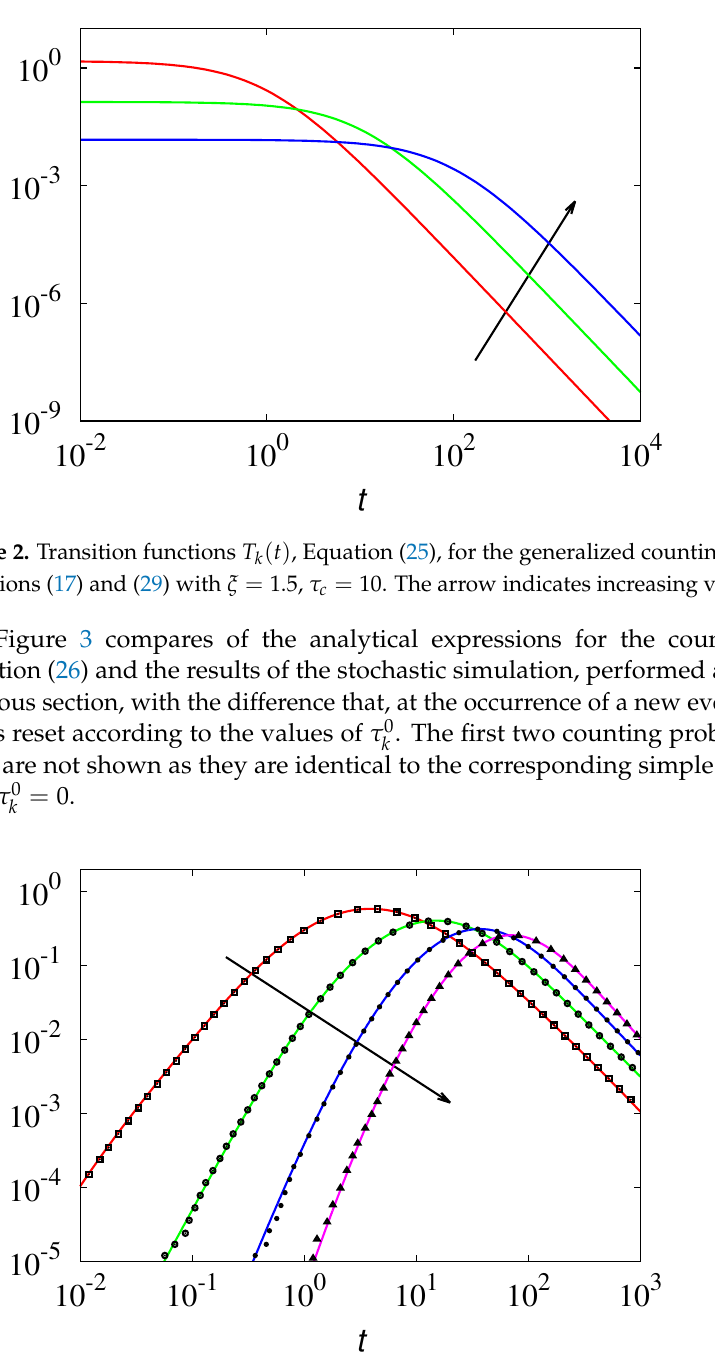
Figure 3. P k ( t ) vs. t for the generalized counting process defined by Equation (15) by Equations (17) and (29) with ξ = 1.5, τ c = 10. The arrow indicates increasing values of k =